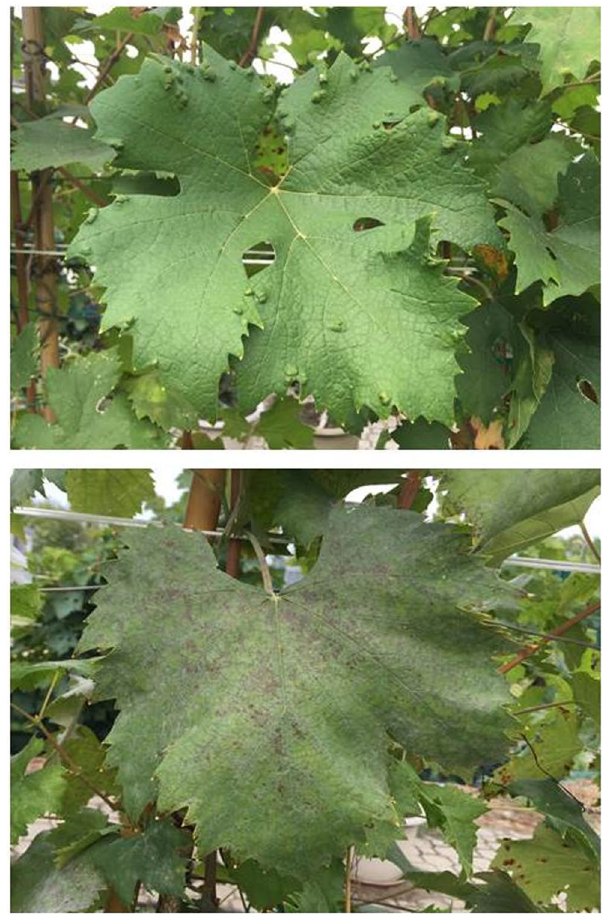
Figure 6. Morphology of a mature leaf of PS-Access (top) and PS-SG